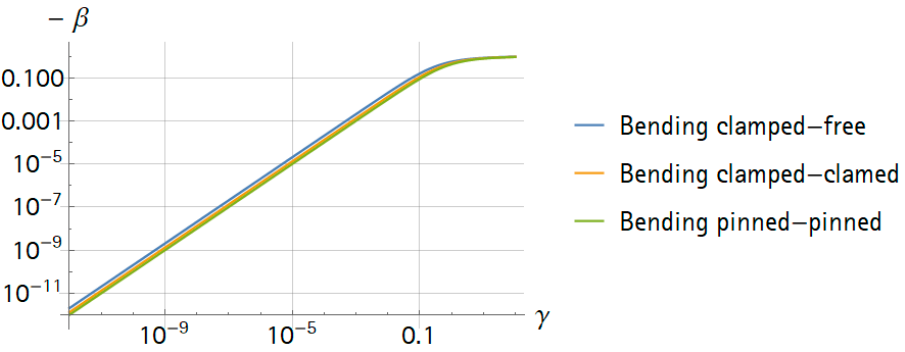
Figure 2. Relative frequency changes ( − β ) of bending modes over mass ratio ( γ